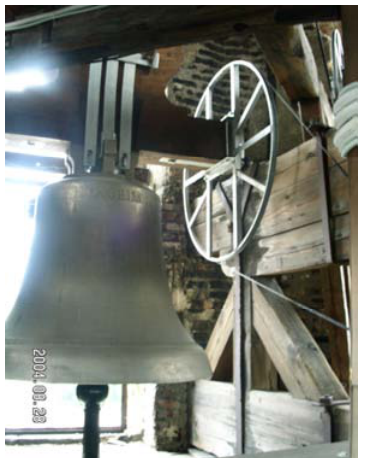
Fig. 3. The biggest bell “Joachim” and its wooden support